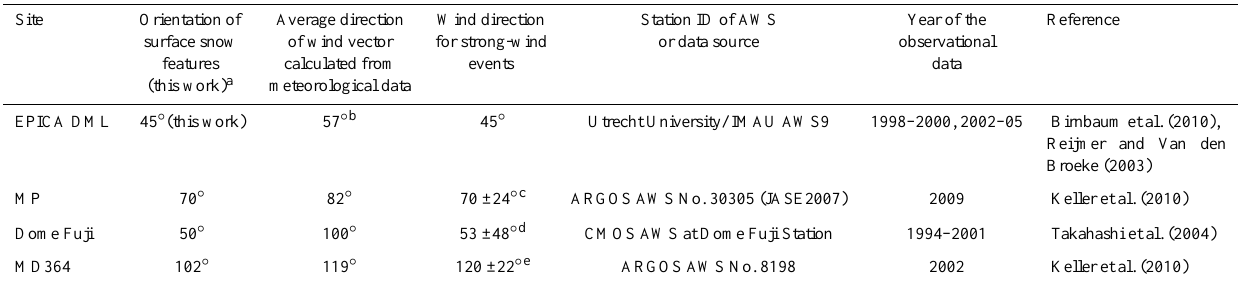
Table 4. Comparison between orientation of surface snow features and wind field